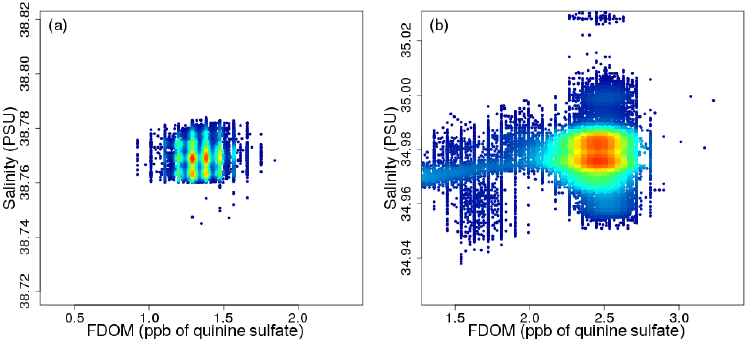
Figure 2. Salinity (PSU) vs. FDOM (ppb of quinine sulfate) data collected during drift at the 1000m parking depth for two Biogeochemical- Argo floats: (a) float WMO 6901768 (eastern Mediterranean Sea) showing no FDOM changes for a similar salinity (7 months of sampling) and (b) float WMO 6901474 (North Atlantic subtropical gyre) showing a decrease in FDOM for a similar salinity (more than 24 months of sampling). In plot (b) , FDOM values around 2.5ppb of quinine sulfate represent measurements collected during the first 2 years of the float lifetime and which have not been discarded. Colors indicate density of measurements for a given salinity vs. the FDOM value (red > blue).